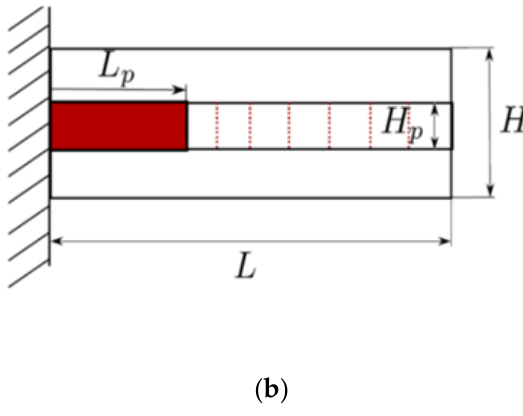
Figure 10. ( a ) Fluttering flag; ( b ) piezoelectric sectioned fluttering flag. Hassan et al. [173] used a piezoelectric transducer-based model to capture